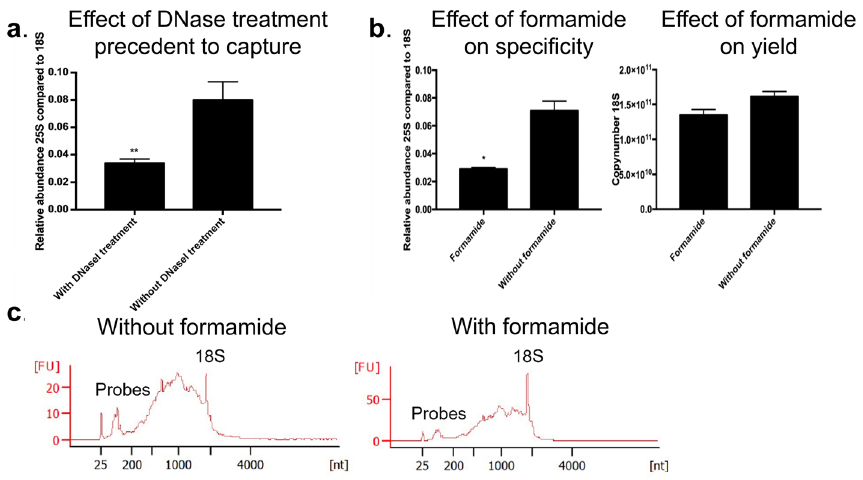
Figure 6. Key optimizations ( a ) Relative abundance of 25S rRNA compared to 18S rRNA after capture with 18S probes comparing with and without DNase treatment. Values are calculated as the amount of background after capture divided by the amount of 18S after capture. ** represents a two-tailed p-value < 0.01. Error bars represent SEM, n = 2. Significance is determined with an unpaired t-test. ( b ) Effect of formamide * represents a two-tailed p-value < 0.05. (Left panel) Relative abundance of 25S compared to 18S with or w/o formamide. Values are calculated as the amount of 25S after capture divided by the amount of 18S after capture. Error bars represent SEM, n = 2. (Right panel) Yield after capture with or w/o formamide. Values are calculated by extrapolation on a standard curve of the plasmid PGEM-T_fulllength18S. Error bars represent SEM, n = 2.